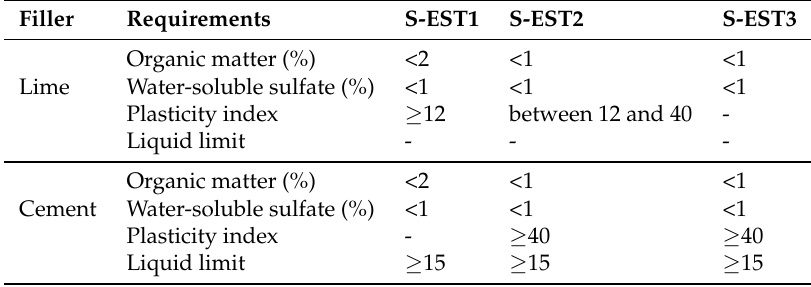
Table 2. PG-3 technical requirements for stabilized soil used in the construction of road